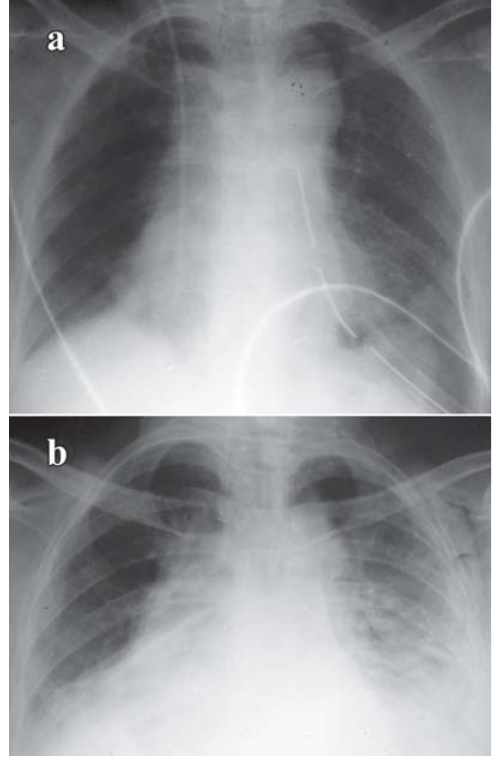
Fig. 2 - Chest radiograph in the immediate postoperative period (a) and at one month following surgery